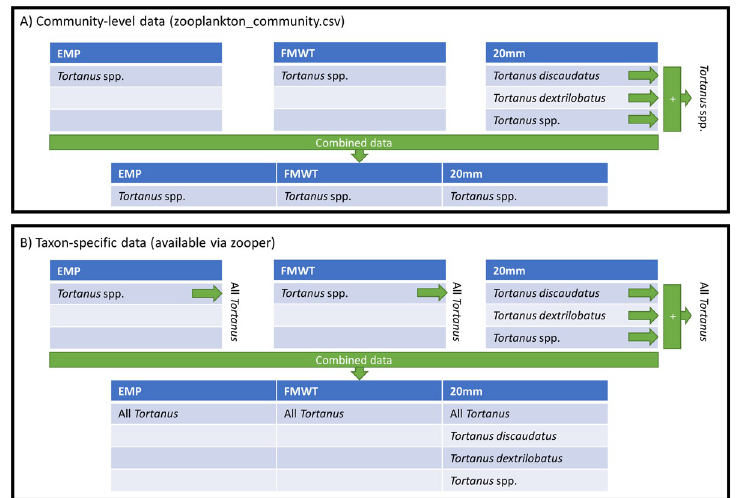
Fig 5. Two methods used to resolve differences in taxonomic resolution among surveys. Methods are illustrated using the genus Tortanus as an example, but issues with other taxa are resolved with the same methods. A) Taxonomic resolution is resolved to create a dataset for community-level analysis (available via zooplankton_community.csv or zooper). Since not all surveys measure Tortanus abundance to the species level, but all surveys measure Tortanus to the genus level or lower, the counts of Tortanus for all surveys are summed to the genus level ( Tortanus spp.). The species- level data are then removed from the integrated dataset since their counts are included in Tortanus spp. B) Taxonomic resolution is resolved to provide all possible information on taxa of interest (available via zooper). All Tortanus counts are summed to an “All Tortanus ” category, which is comparable across surveys. The individual Tortanus categories ( Tortanus spp., Tortanus discaudatus , and Tortanus dextrilobatus ) are retained in the integrated dataset.